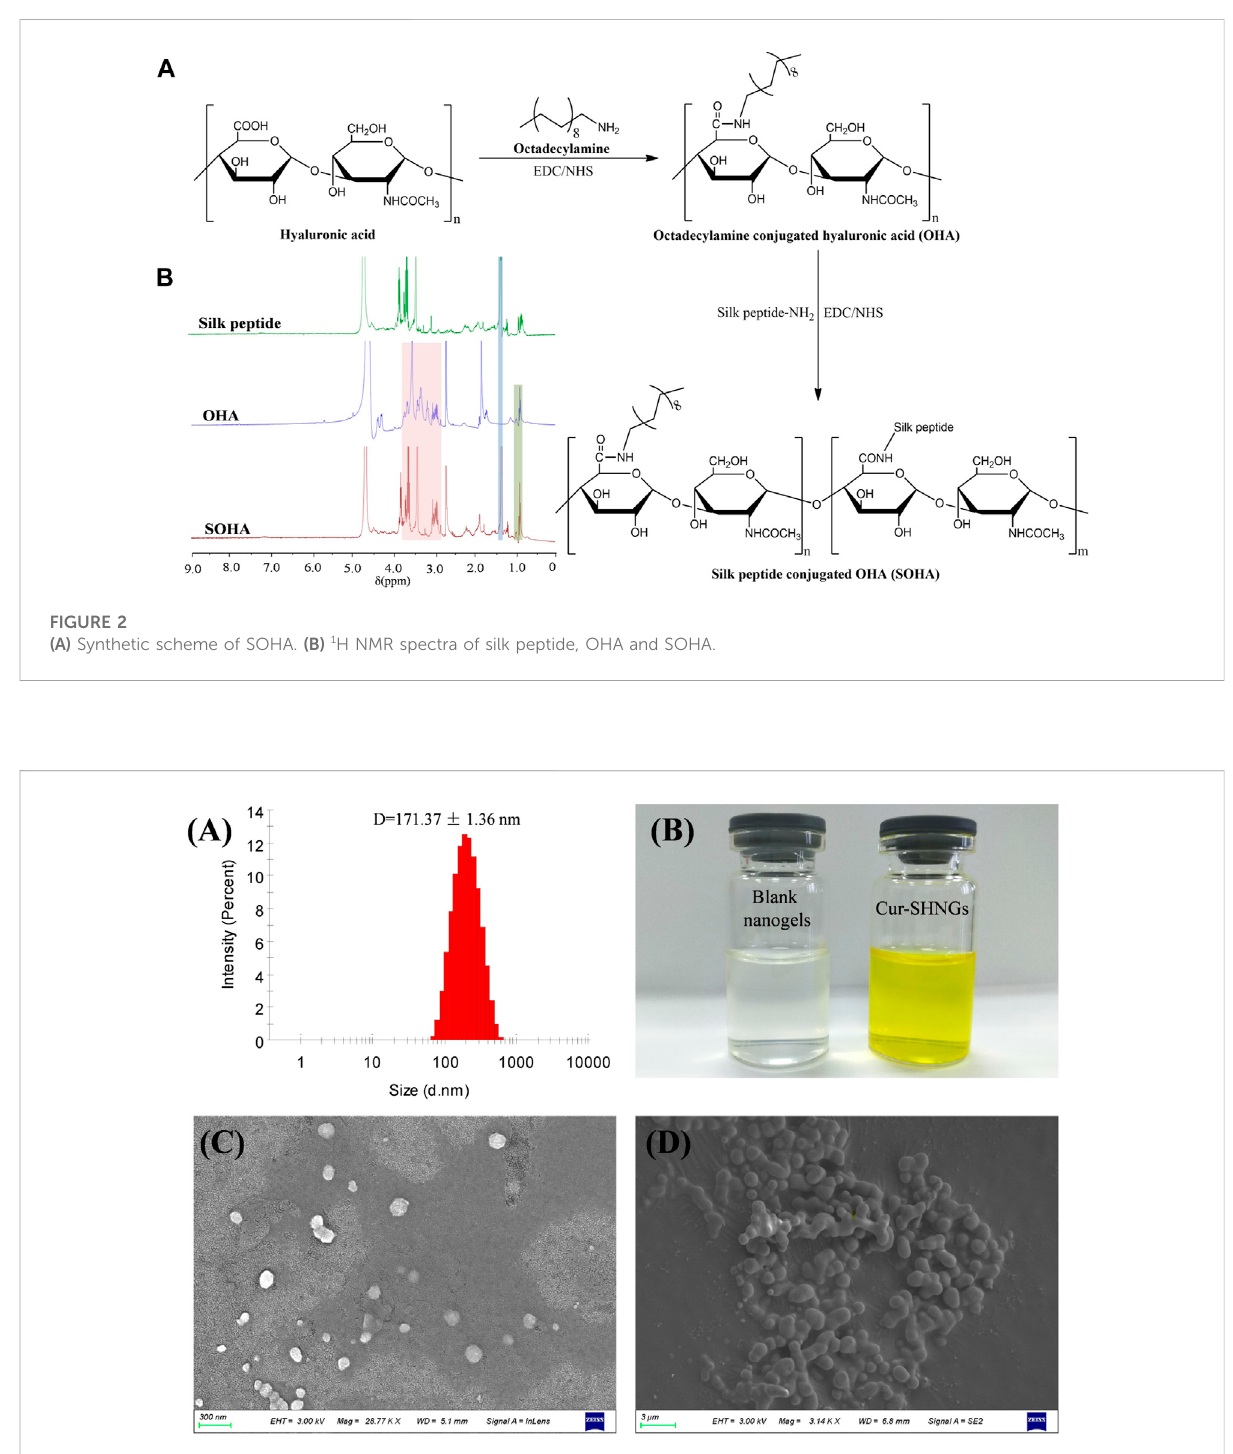
FIGURE 3 Characterization of Cur-SHNGs. (A) Particle size distribution of Cur-SHNGs. (B) Appearance of blank nanogels and Cur-SHNGs. (C) SEM image of Cur-SHNGs dispersion. (D) SEM image of lyophilized Cur-SHNGs